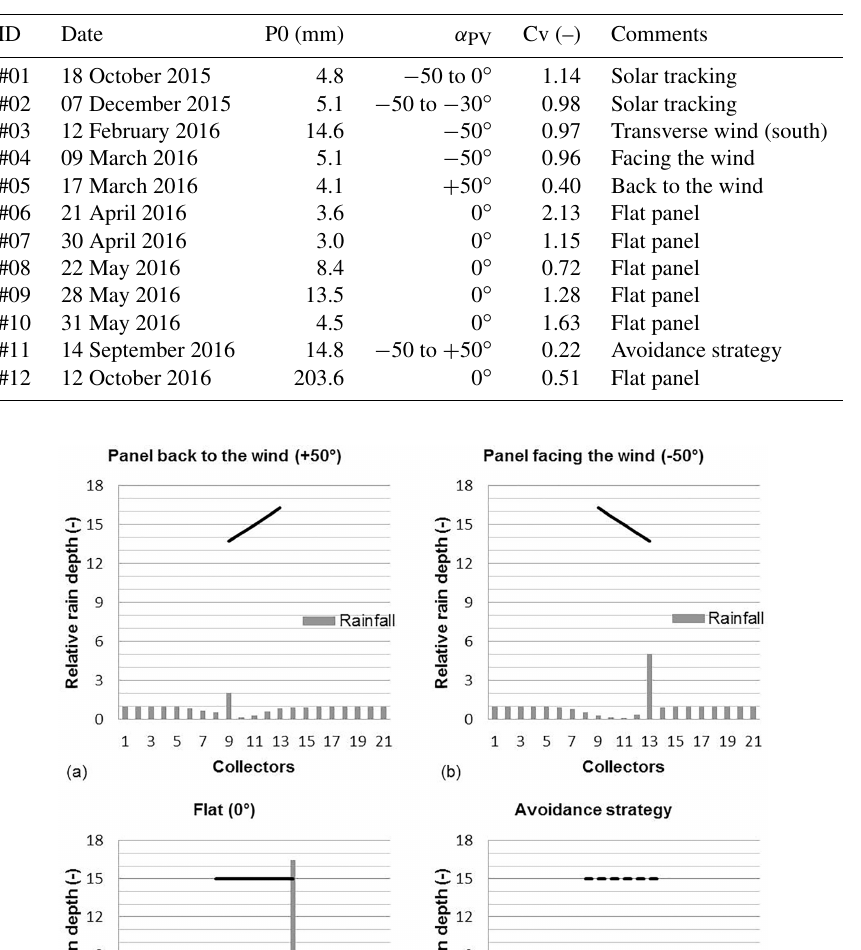
Table 3. Rain events with their identification (ID), date, rain amounts on the control zone (P0), tilting angle of the solar panels ( α PV ) and the associated measured coefficient of variation (Cv) whose highest values indicate the strongest spatial heterogeneities in rain redistribution by the solar panels. In the “Comments” column, avoidance strategy indicates a time-variable α PV angle to minimize rain interception by the panels in real time.